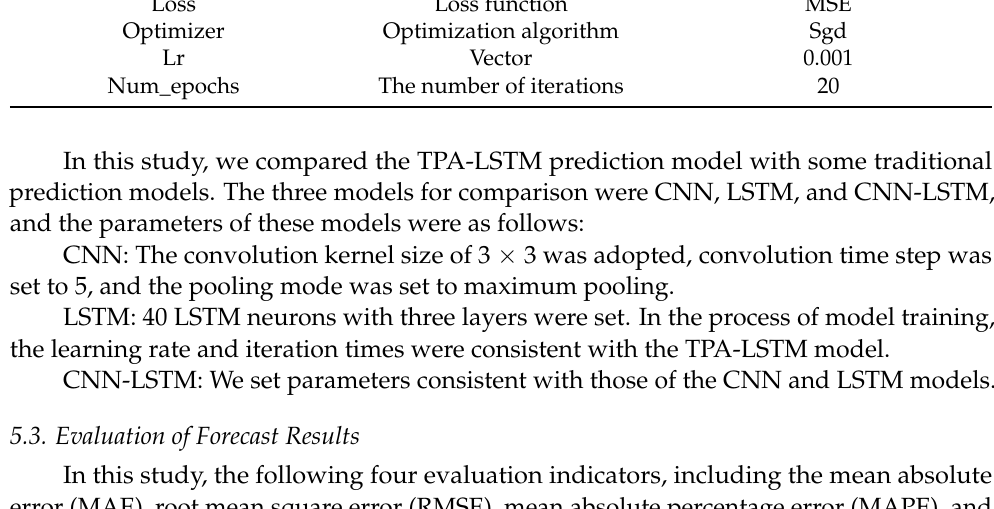
Table 2. Parameter Settings of the TPA-LSTM model. Parameter Instructions Set Activation The activation function Sigmoid Loss Loss function MSE Optimizer Optimization algorithm Sgd Lr Vector 0.001 Num_epochs The number of iterations